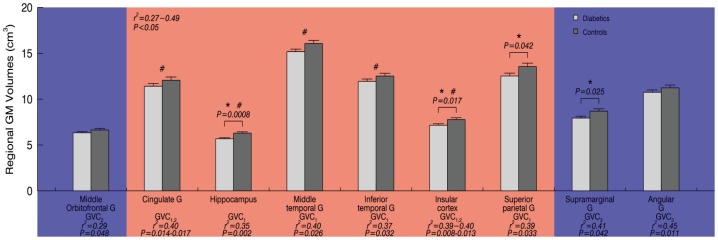
Group differences of regional GM volumes in left hemisphere and their relationship with Multi-Scale GV.‘*’ indicates significant differences between the type 2 DM group (white) and controls (grey) in GM volumes (One-Way ANOVA); regional GM volumes in left hemisphere were correlated with Multi-Scale GV for diabetics and/or controls, blue indicates positive correlation, red indicates negative correlation with each GVC, G' = gyrus, ‘#’ indicates we found similar relationship between Multi-Scale GV and GM volumes in the right hemisphere (r2 = 0.26–074, P<0.05). The bar graphs are presented as mean ± SEM.